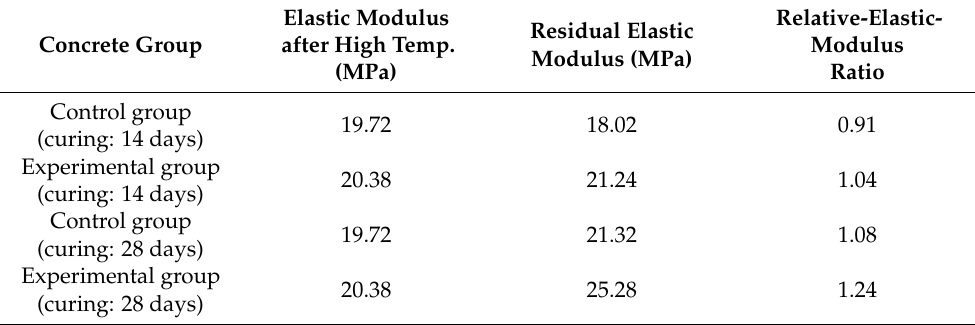
Table 16. Relative-elastic-modulus ratios of the self-healing concrete after exposure to high temperature. Elastic Modulus Concrete Group after High